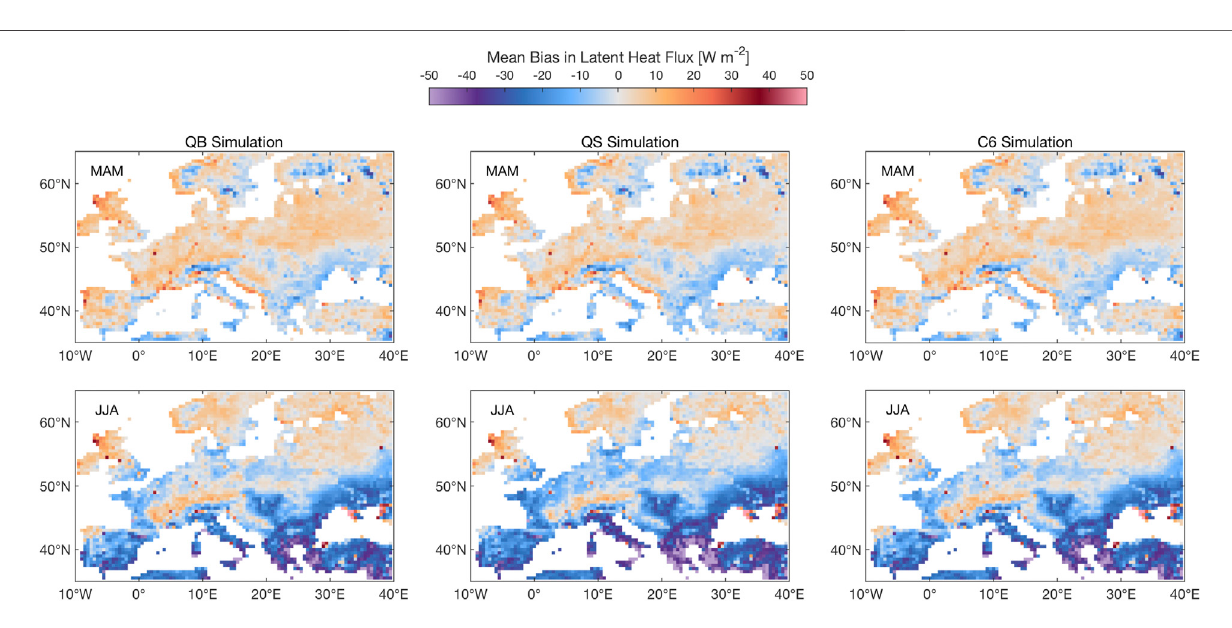
FIGURE 4 | Same as Figure 3 , albeit for latent heat. Units: W m − 2